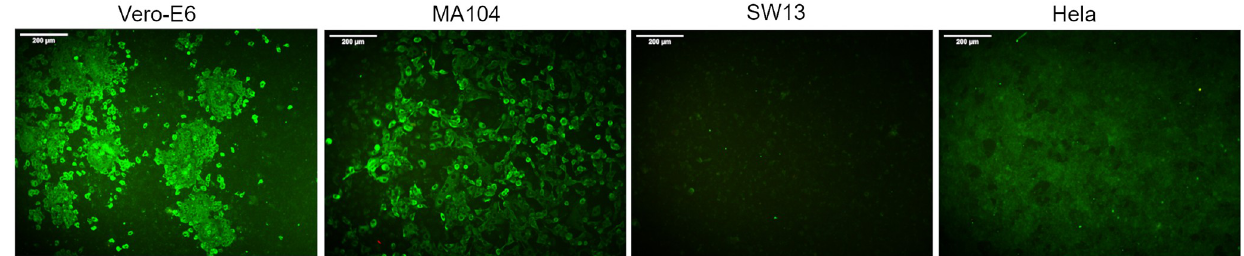
Fig 4. Susceptibility of different cell lines to infection with hCoV-19/Turkey/ERAGEM-001/2020. The cell lines were infected with at an MOI of 0.1, washed after adsorption, and the cell monolayers were overlaid with virus medium containing 1% CMC and incubated at 37˚C with 5% CO 2 for 48 h. After fixation with 10% formaldehyde, the cells were permeabilized with 0.1% Triton X-100 and blocked with 5% skim milk in PBS. The wells were then incubated with a human antibody to the SARS-CoV-2 nucleocapsid protein (1:2500) (GenScript; HC2003) for 1 h in TBST (100 mM Tris–HCl pH 8.0, 1.5 M NaCl, 1% Tween 20) at 37˚C, followed by washing three times, after which the cells were incubated for 1 h with goat anti-human IgG conjugated to FITCH (Southern Biotech, USA). The antibody-labeled cells were detected and analyzed by immunofluorescence microscopy (Leica, DFC450C). Scale bars = 200 μ